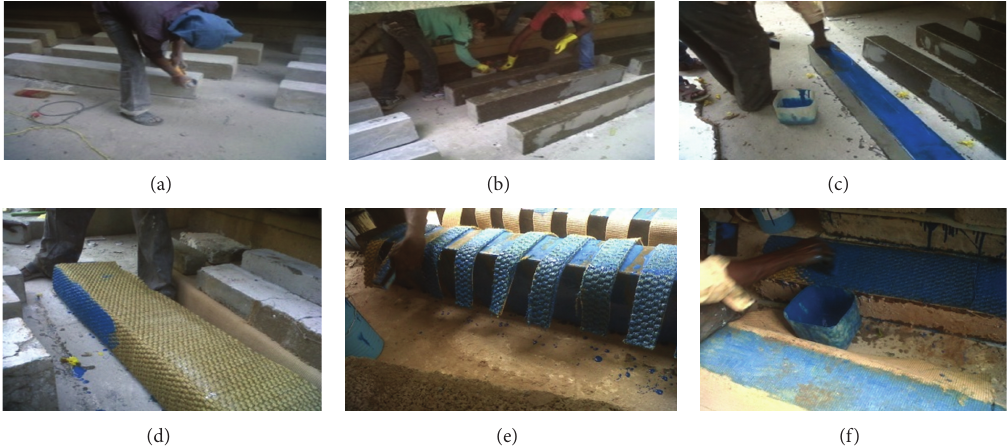
Figure 5: (a) surface preparation of beams by grinding; (b) primer application on beam surface; (c) application of epoxy hardener mix on the beam; (d) bonding of woven sisal (full wrap); (e) bonding of woven sisal (strip wrap); (f) final coating of epoxy hardener mix on the bonded fabric.